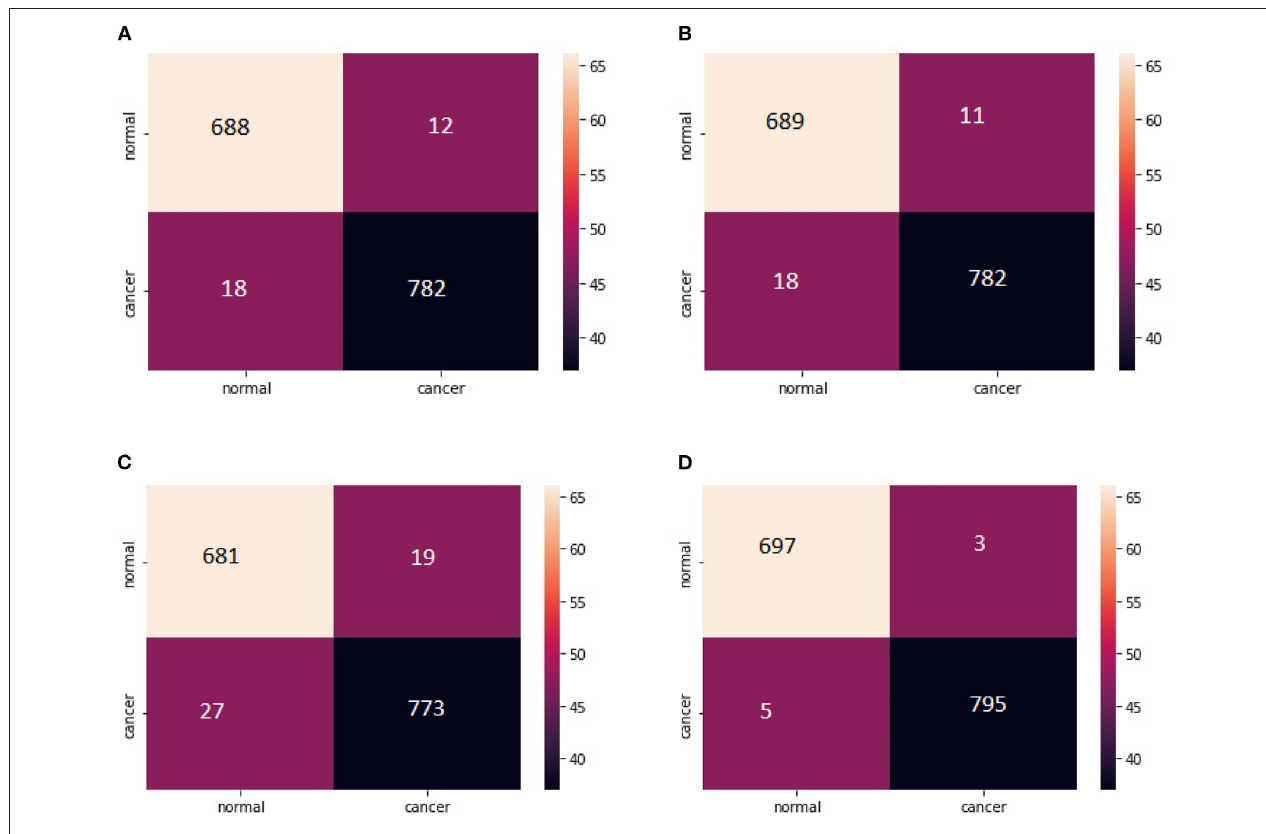
FIGURE 12 | (A) Confusion Matrix MobileNet. (B) Confusion Matrix XceptionNet. (C) Confusion matrix VGG-16. (D) Confusion matrix